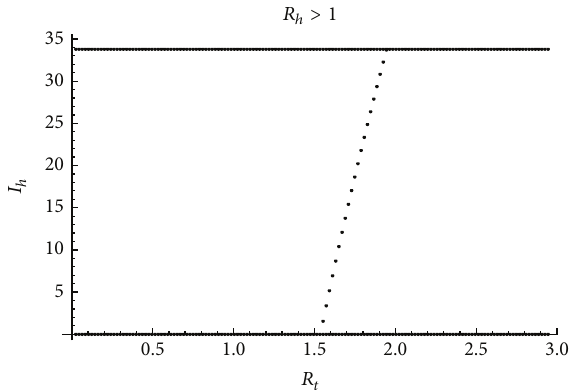
Figure 5: The bifurcation diagram for 𝑅 𝑡 versus 𝐼 ℎ𝑡 .